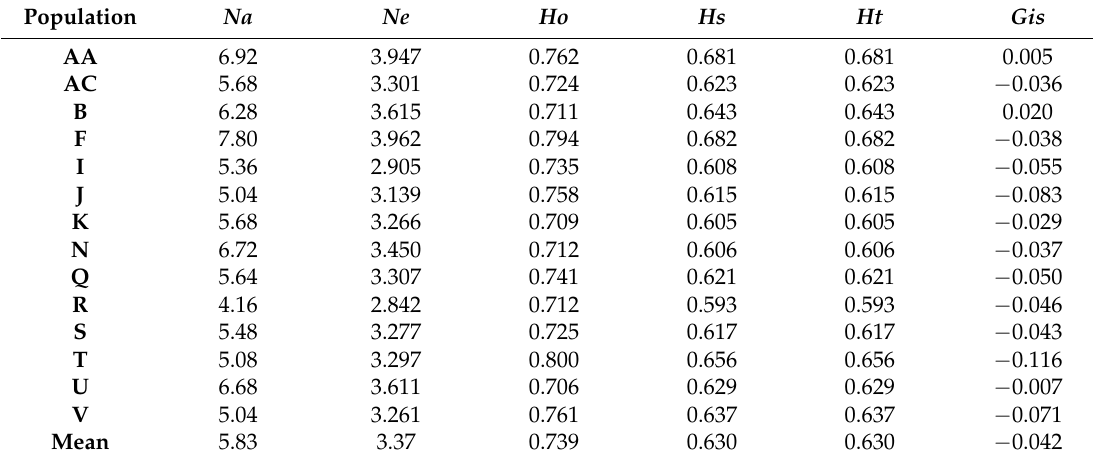
Table 3. Genetic diversity of 175 A . cremastogyne trees representing 14 populations in Sichuan Province as detected by allele sizes at 25 simple sequence repeat